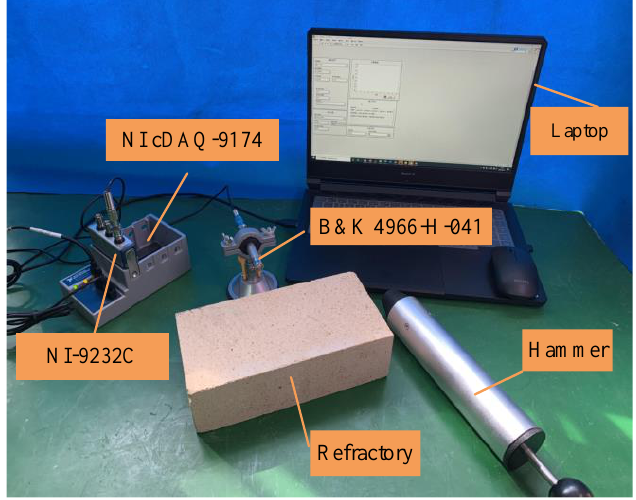
Figure 3. Schematic of the experimental setup.